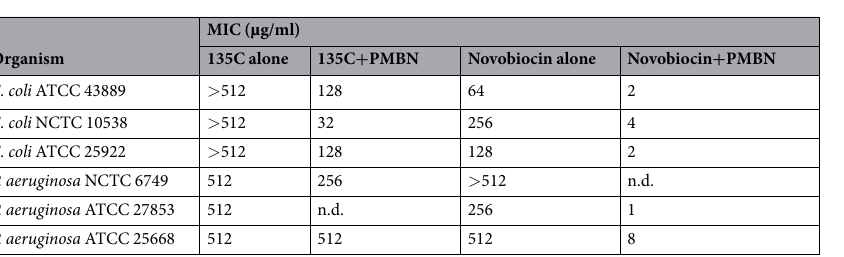
Table 2. Minimum inhibitory concentrations of 135C for Gram-negative bacteria in the presence and absence of PMBN. n.d. = no data. PMBN concentration 5 μ g ml − 1